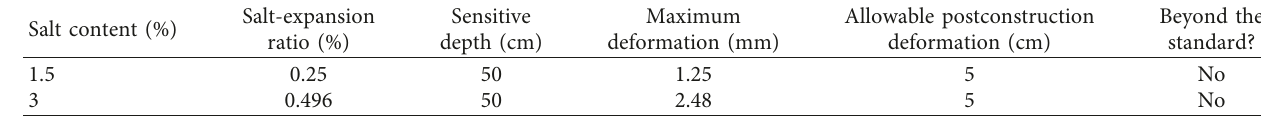
Table 4: Estimation results of the salt-expansion amount.